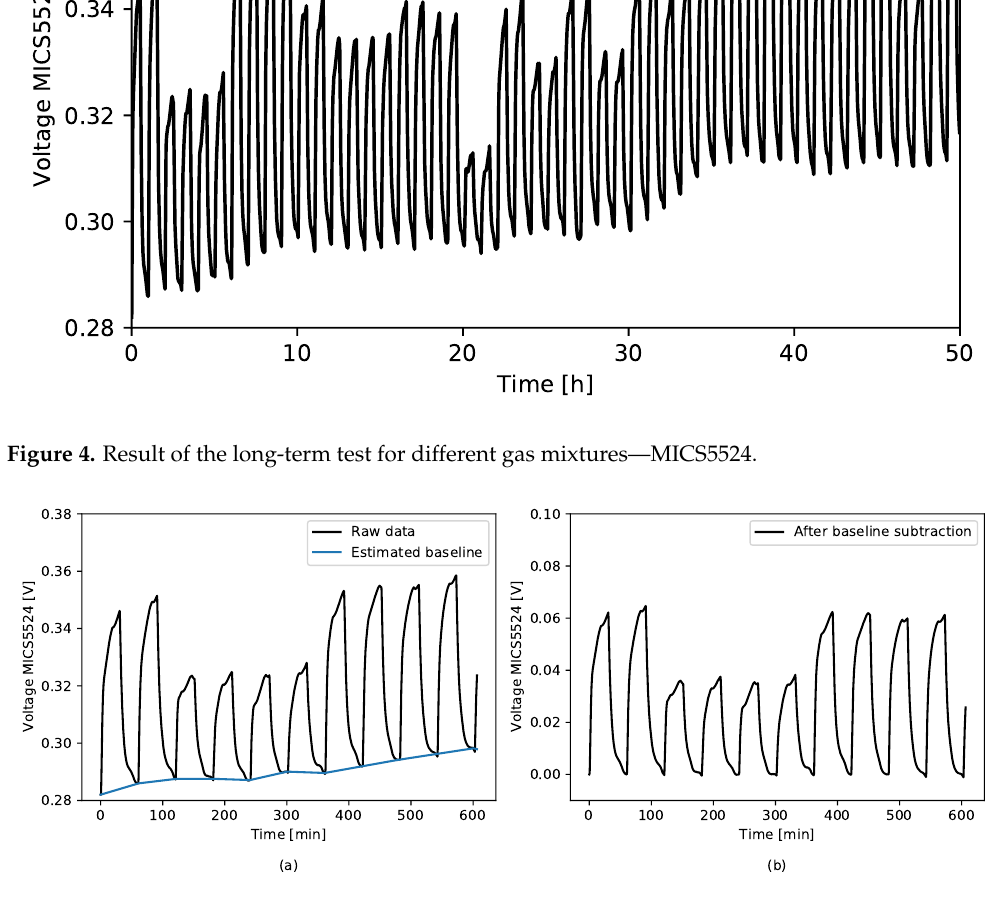
Figure 5. Baseline subtraction. ( a ) Sensor raw response with fitted baseline; ( b ) result of the baseline